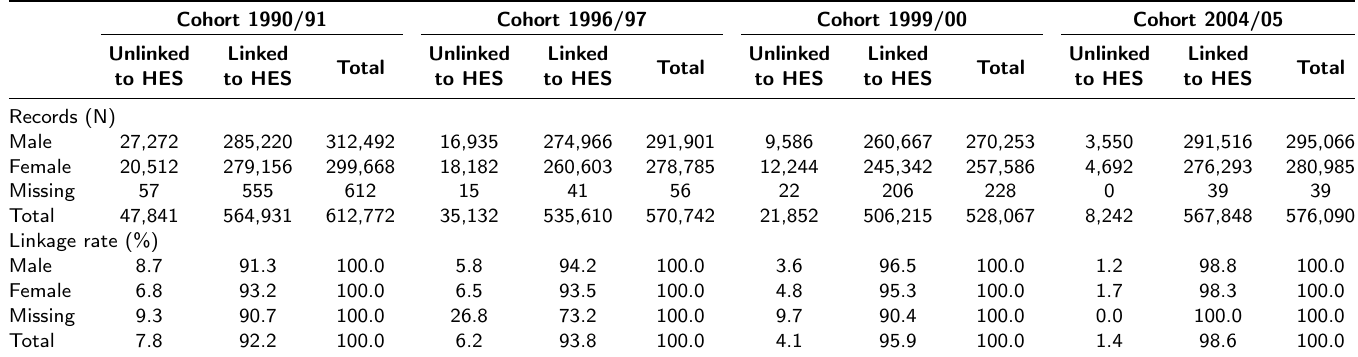
Supplementary Table 8.3: Linking rate by sex and cohort